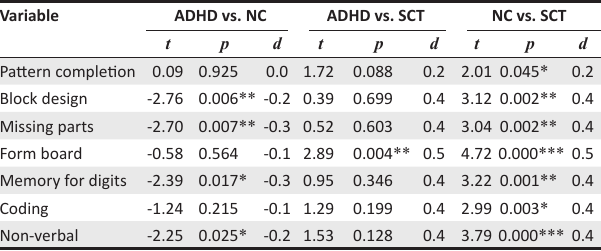
TABLE 8 : t -test scores for the differences in the mean scores of the non-verbal subtests between the three groups. Variable ADHD vs. NC ADHD vs. SCT NC vs.